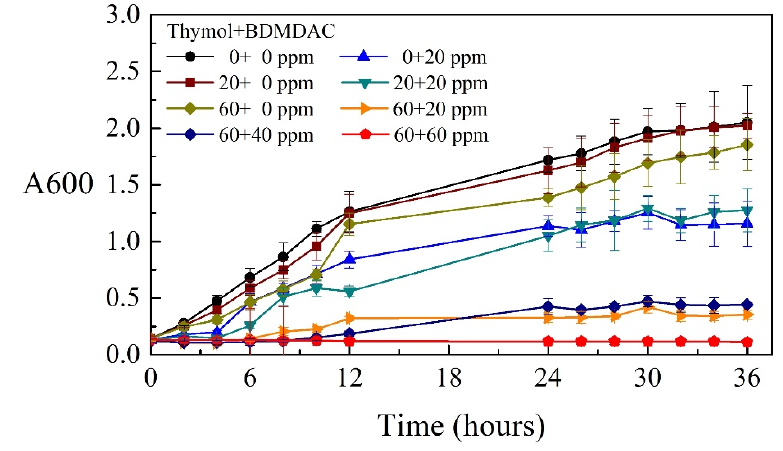
Figure 4. Microbial growth curves of varying concentrations of composite biocides applied to the Zuoying inocula.